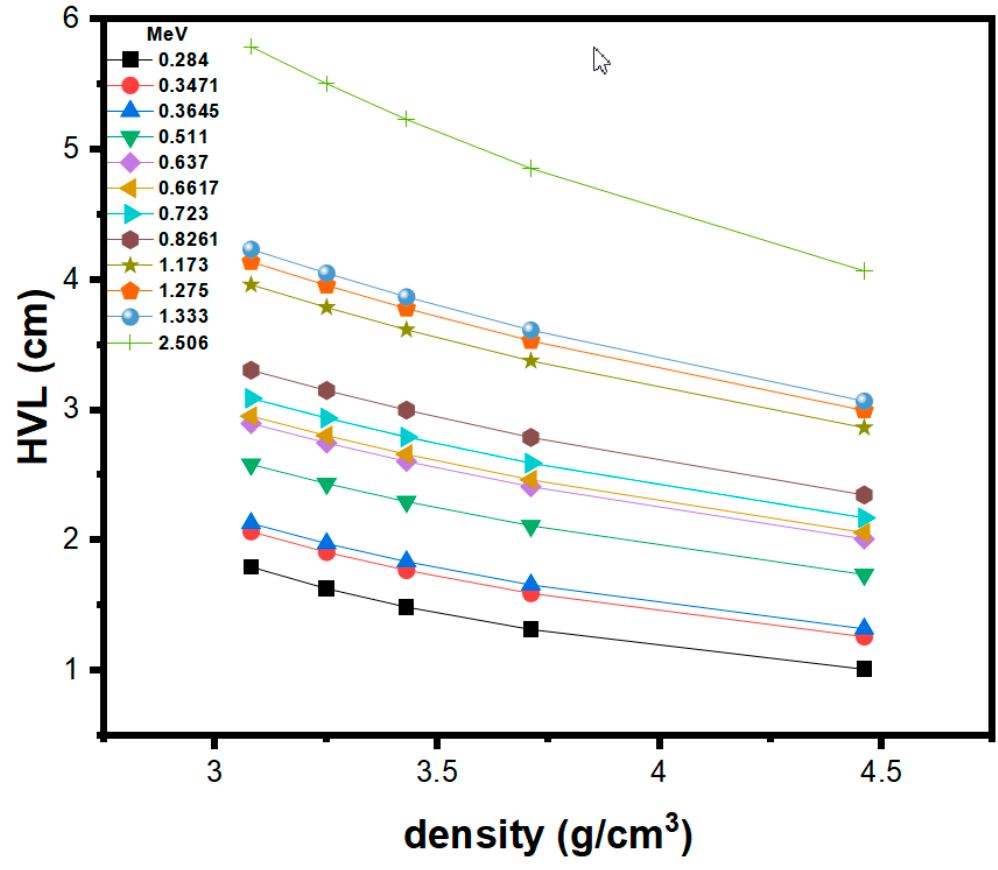
Figure 8. The half value layer (cm) as a function of the density of the TeBYbX glasses. For the chosen calcium borotellurite glasses (TeBYbX), we determined the tenth value layer for the samples with lowest and highest TeO 2 contents, namely TeBYb1 and TeBYb5, then we calculated the ratio between the TVL for the TeBYb1 and TeBYb5 glasses (TVL TeBYb1 /TVL TeBYb5 ). The results are presented in Figure 9. The aim of this figure is to understand the influence of the 10 and 54 mol% of TeO 2 on the thickness of the TeBYbX samples that can attenuate the gamma rays. By examining the data presented in Figure 9, one can easily understand that TeBYb1 has a higher TVL than TeBYb5, because the ratio is almost larger than 1. The TVL TeBYb1 /TVL TeBYb5 decreases with the increasing energy; it starts with maximum value of 1.78 at 0.284 MeV, then reduces quickly with a further increase in energy. The TVL TeBYb1 /TVL TeBYb5 at 0.347 and 0.511 MeV are 1.64 and 1.61. We can conclude from this figure that increasing the amount of TeO 2 from 10 to 54 mol% in the selected calcium